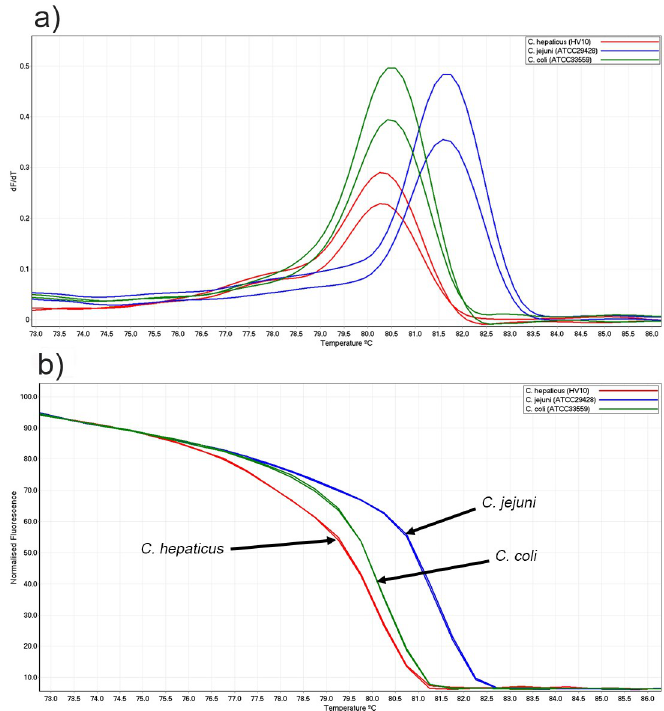
Fig 1. Conventional and normalised melt curve analysis of three Campylobacter reference strains. (a) Conventional and (b) normalised HRM curve analysis of PCR ( hsp60 gene) amplicons.